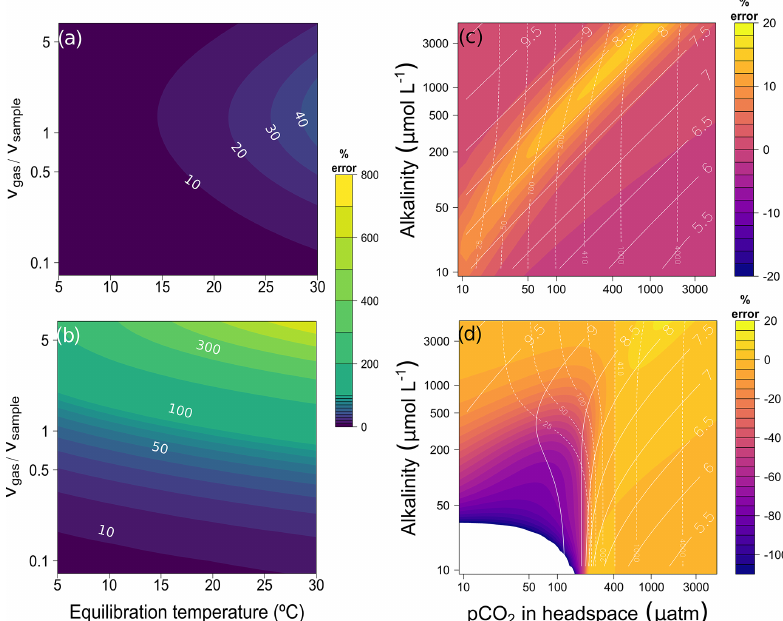
Figure 3. Error (%) when applying simple headspace calculation depending on headspace ratio and equilibration temperature for (a) 100µmol L − 1 and (b) 1000µmolL − 1 alkalinity. Panels (a) and (b) were constructed using highly undersaturated conditions (headspace p CO 2 = 50µatm after equilibration and field water temperature of 20 ◦ C). The values of some isolines are added for reference. (c) Error (%) applying our complete headspace method when the alkalinity value supplied for calculations is off the real alkalinity of the sample by + 50%. The results are for hypothetical water samples of different alkalinity and p CO 2 in the headspace after equilibration using CO 2 -free gas headspace, a headspace ratio of 1:1, and an equilibration and field temperature of 20 ◦ C. (d) Like panel (c) but with air headspace. All calculations assume a pressure of